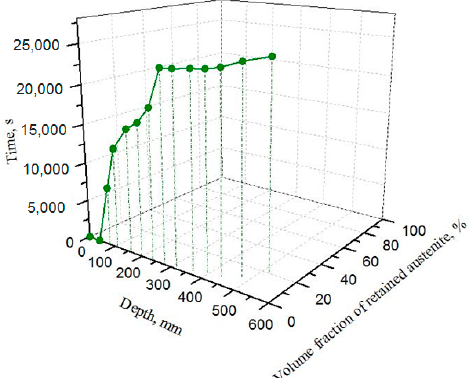
Figure 13. Calculated retained austenite distribution of condition (D).